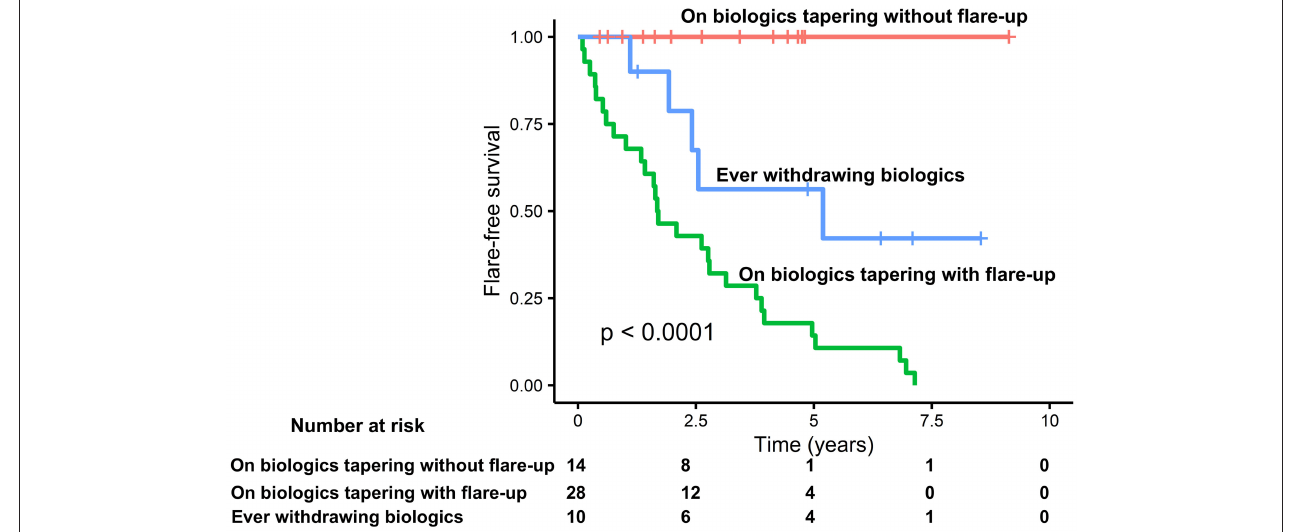
FIGURE 3 | Kaplan–Meier plot of time to enthesitis related arthritis (ERA) disease flare-up. Flare-up was defined as loss of at least two items of the Wallace criteria as well as when the attending physician intensified treatment because of elevated disease activity. Time to flare was defined as the time from the date initiating biologics tapering to the date of the first flare visit. Patients without flare-up were censored at the date of the latest